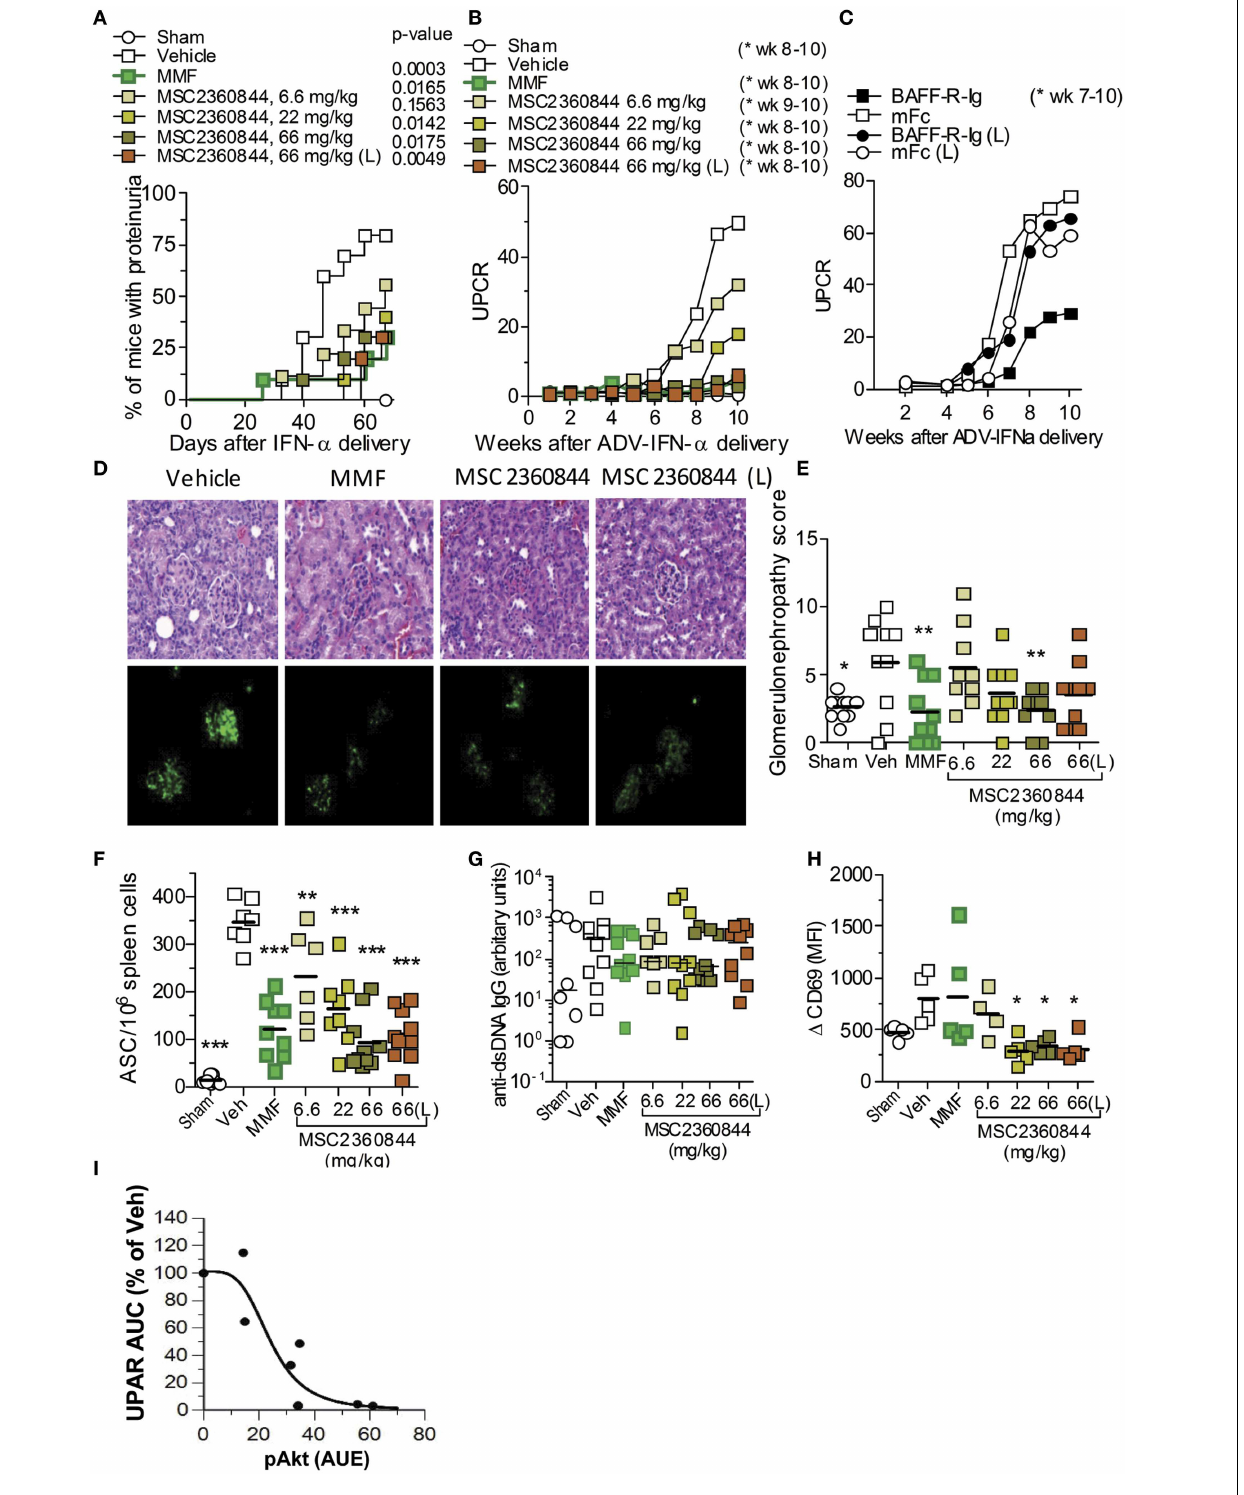
(C) UPCR over time in mice treated with BAFF-R-Ig or mFc as control. (D) Kidney sections obtained at the end of experiment were stained with H&E (upper panel) or immunofluorescence (lower panel) with anti-IgG2a FITC Ab. Magnification, 200 × . (E) Histopathological scores